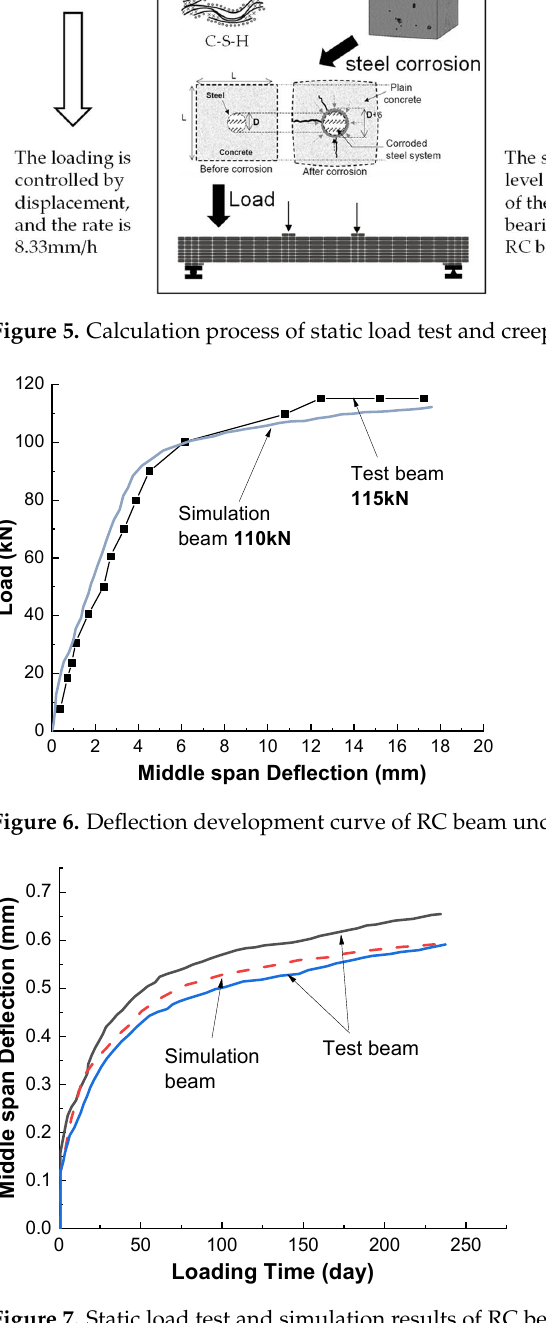
Figure 5. Calculation process of static load test and creep test.